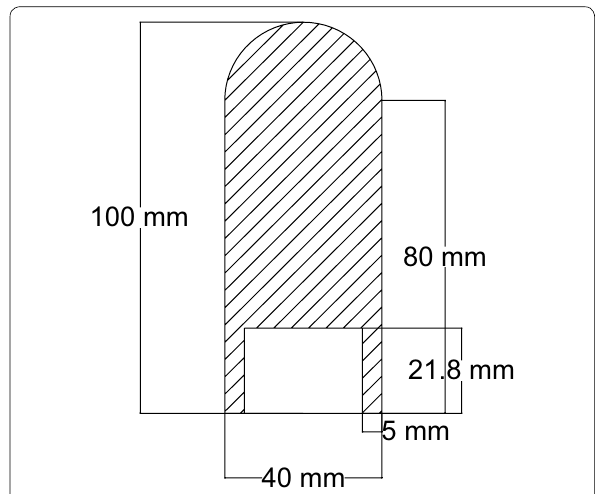
Fig. 3 Details of the spherical nose projectile (Almusallam et al. 2015).